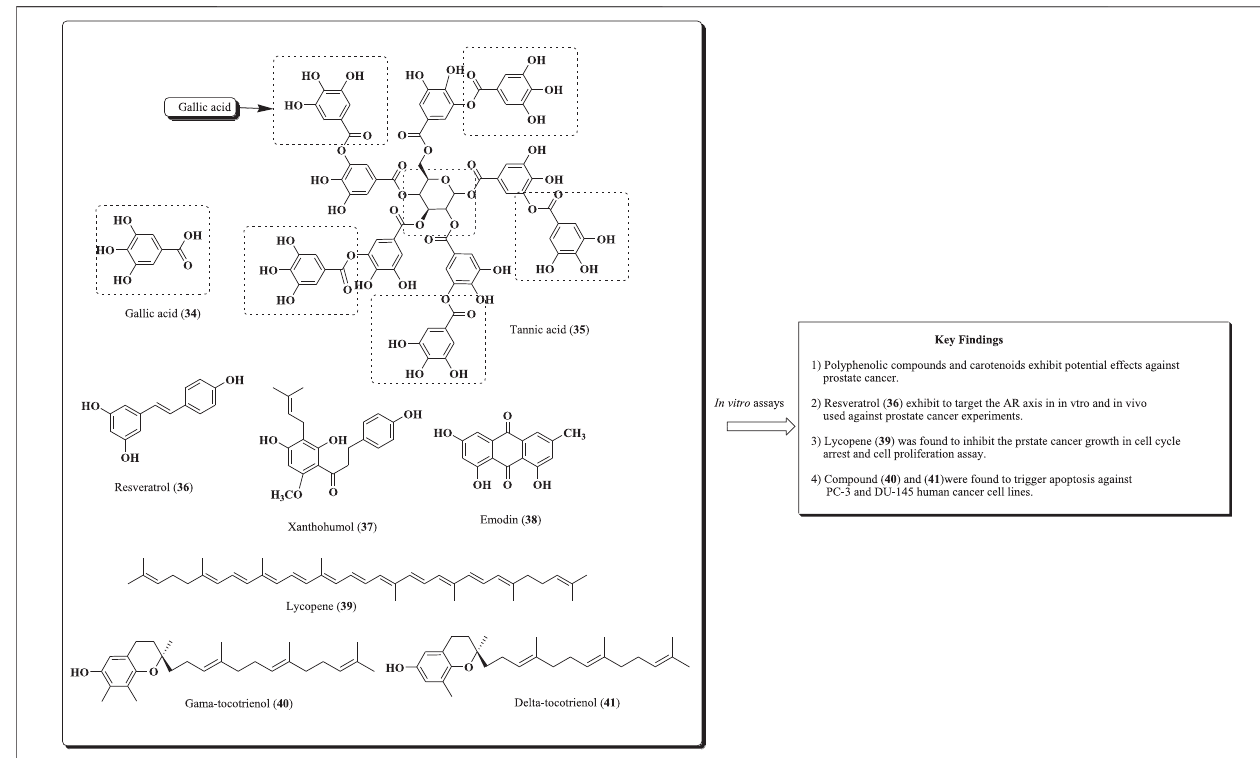
FIGURE 12 | Structure of compounds (34 – 41) along with important key fi ndings.